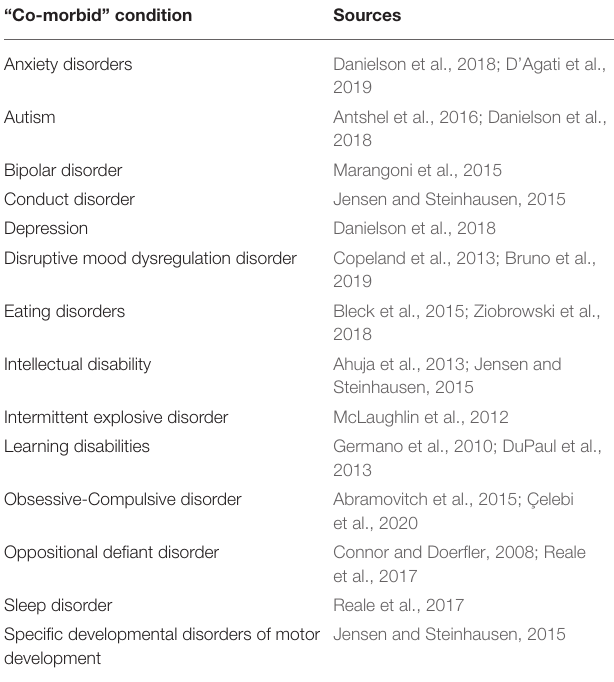
TABLE 1 | Examples of ADHD “co-morbidity” (in alphabetical